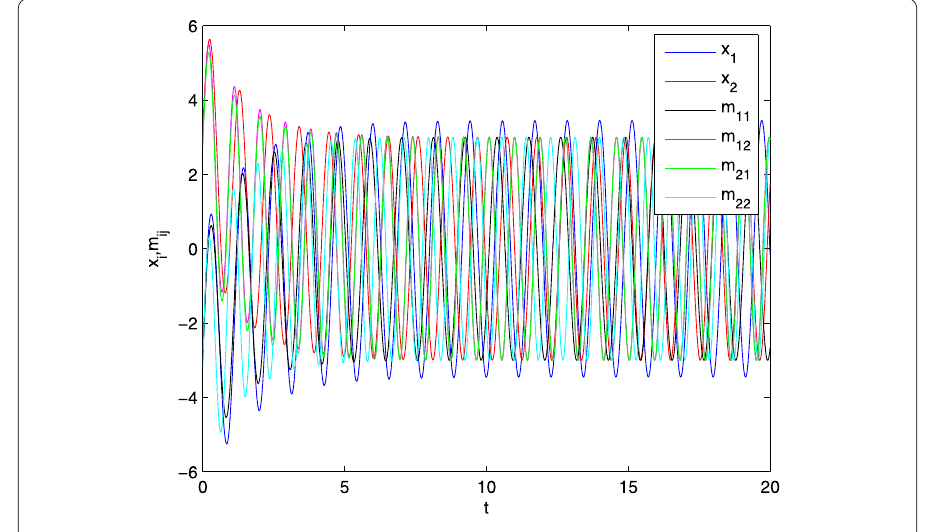
Figure 1 For i , j = 1,2, trajectories of x i ( t ) and m ij ( t ) in system (4.1)